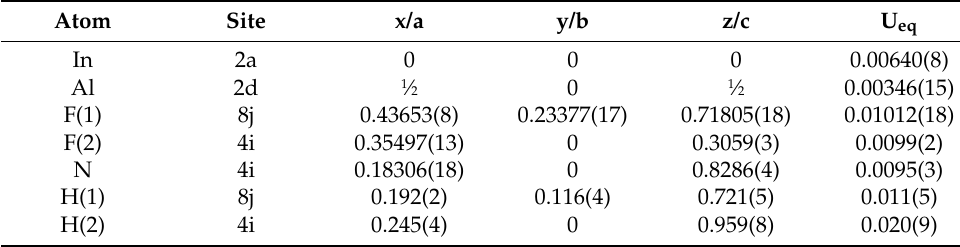
Table 3. Fractional atomic coordinates and isotropic displacement parameters (in 10 4 pm 2 ) of InAlF 6 (NH 3 ) 2